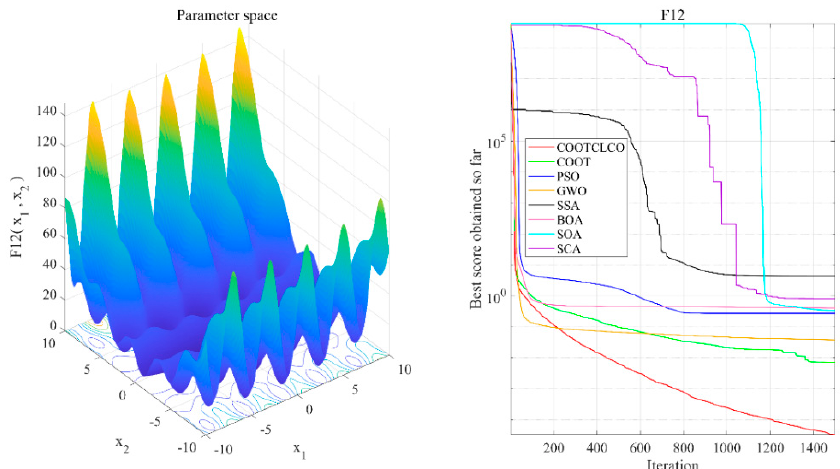
Figure 9. Test function F11 and comparison of convergence curves on F11.